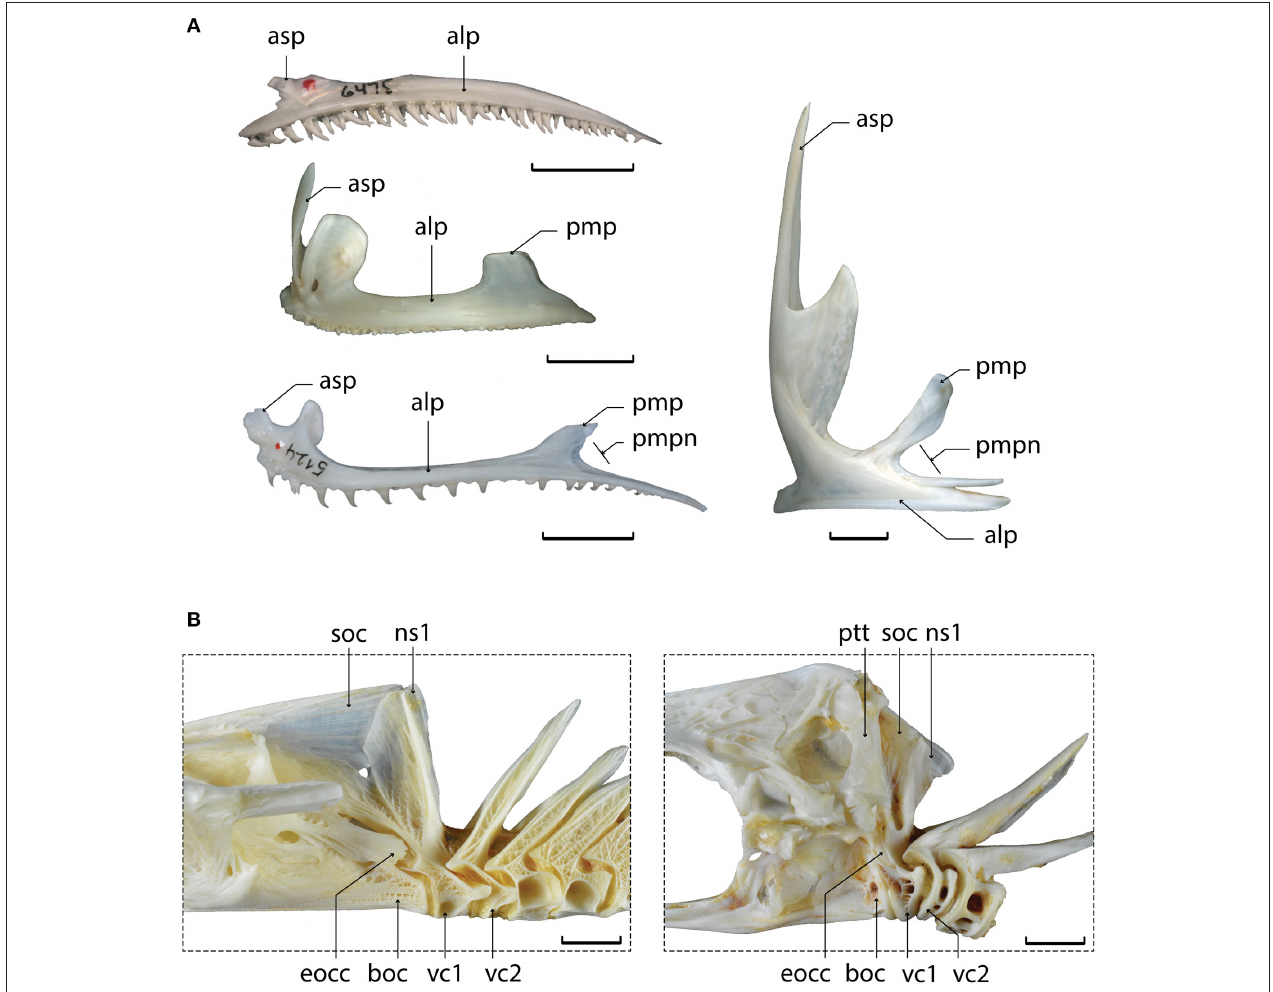
FIGURE 7 | Examples of synapomorphies for Gadiformes + Zeiformes. (A) Left premaxillae in lateral view of (from top to bottom and left to right) Synodus scituliceps , PB-6475; Dicentrarchus labrax , MNHN uncataloged; Merluccius gayi , PB-5124; Zeus faber , MNHN uncataloged. (B) Posterior region of the neurocranium and anteriormost vertebrae in lateral view of Merluccius merluccius , MNHN uncataloged; Zeus faber , MNHN uncataloged. Abbreviations: alp, alveolar process of the premaxilla; asp, ascending process of the premaxilla; boc, basioccipital; eocc, exoccipital condyle; ns1, neural spine of the first vertebra; pmp, postmaxillary process of the premaxilla; pmpn, posterior notch on the postmaxillary process of the premaxilla; ptt, posttemporal; soc, supraoccipital; vc, vertebral centrum. Scale bar equals 10 mm. Photos D. Davesne and Osteobase